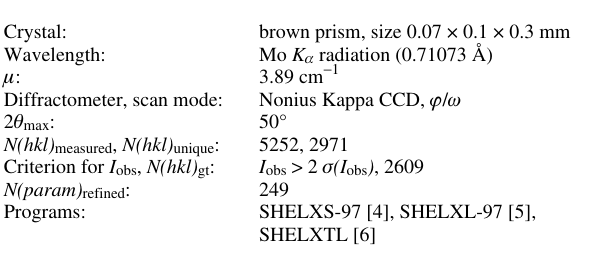
Table 1. Data collection and handling.